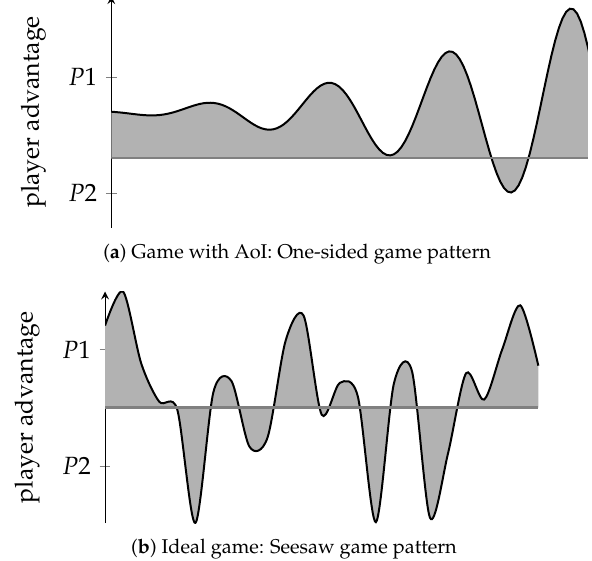
Figure 1. A rough illustration of the game progression curves for a game with advantage of initiative and for an ideal